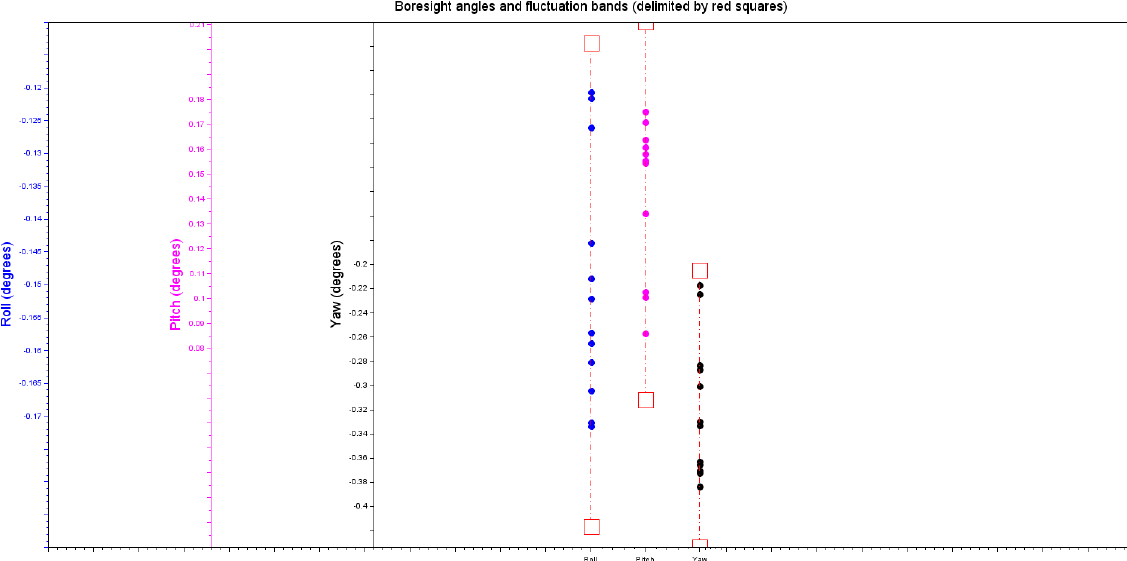
Figure 15. Boresight angle results of reproducibility tests for ten similar pattern of lines in different conditions and fluctuation bands (in delimited by red squares for each boresight